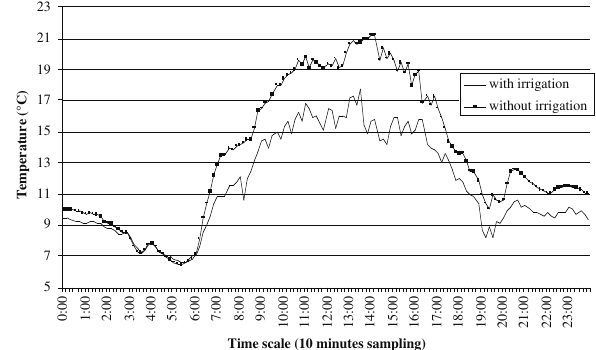
Figure 5. The effect of daytime irrigation on the daily distribution of temperature in pear plantation on a windy day when the average wind speed was higher than 10m/s. 29th of April 200